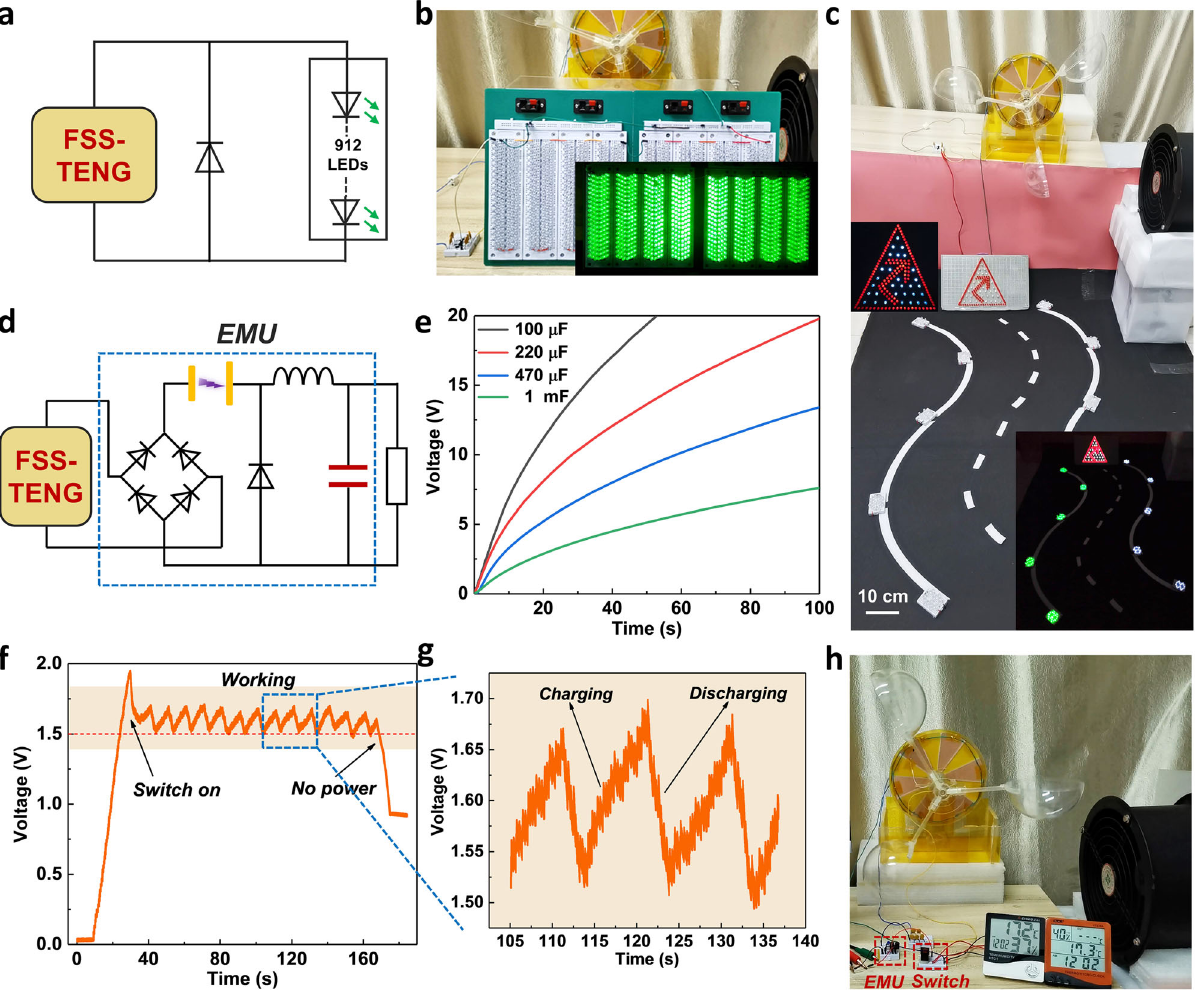
Fig. 5 Demonstration of the FSS-TENG to drive devices. a Circuit diagram and b real photographs of the FSS-TENG for lighting 912 LEDs. c Directly driving the simulated road warning lights with 348 LEDs at a wind speed of 5 m s − 1 (all of the lights have a diameter of 5 mm). d Circuit diagram of the FSS-TENG with an energy management unit (EMU) for powering electronic equipment. e Voltage curves of capacitors charging at 5 m s − 1 wind speed with EMU. f Voltage – time curve of two temperature hygrometers in parallel at 3 m s − 1 wind speed with the EMU. g The detailed voltage curve of the selected area in f . h The real photograph of the temperature hygrometers powered by the